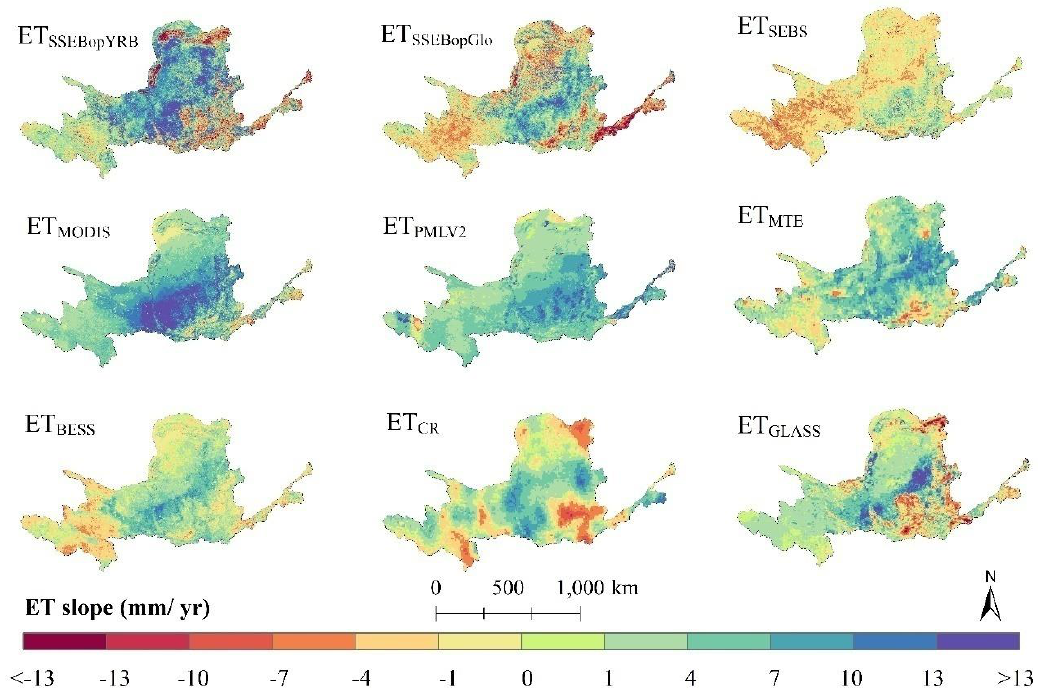
Figure 6. Annual ET trend comparison of ET SSEBopYRB and other ET products in the YRB during the years 2003–2015. The ET slope is the change rate of the annual ET, which is calculated using Equation (12). Table 4. Annual ET trend statistics for the whole YRB during the years 2003–2015.